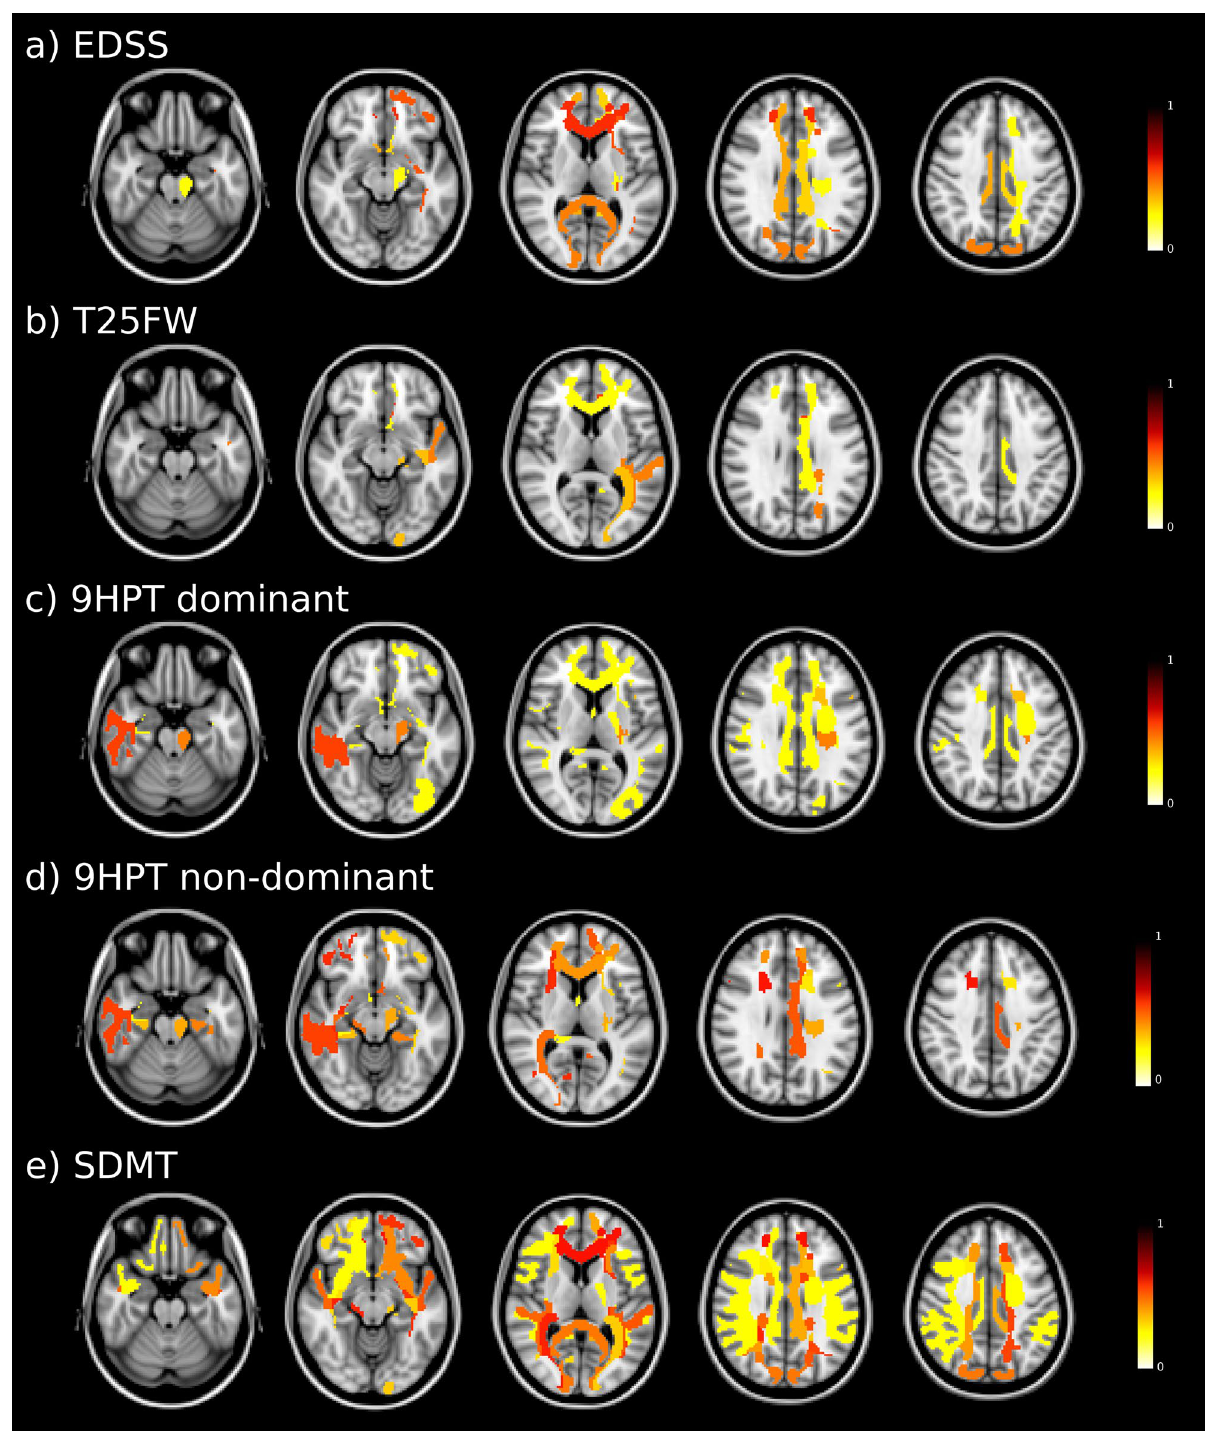
Figure 1. Baseline fractional anisotropy maps associated with follow-up disability outcome. Regions with colours indicate areas of significant associations between white matter fractional anisotropy and clinical outcomes. In the colour scale, 1 represents the maximum coefficient value for the association in each outcome. EDSS Expanded Disability Status Scale; T25FW Timed 25-Foot Walk; 9HPT 9 Hole Peg Test; DH dominant hand; NDH non-dominant hand; SDMT Symbol Digit Modalities